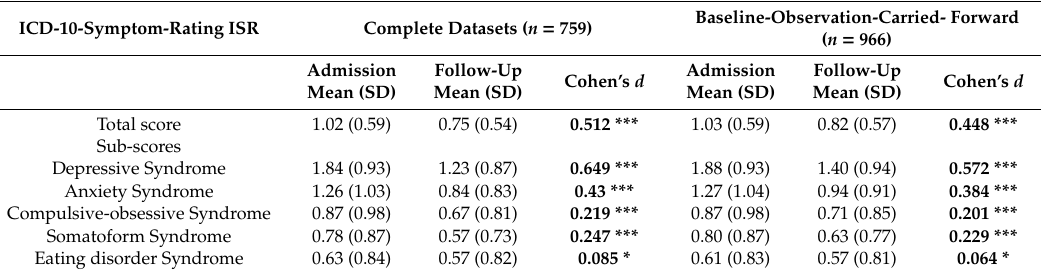
Table 6. Comparison of symptom loads between admission and follow-up of 759 patients with complete data sets and of 966 patients including 207 patients with baseline-observation-carried-forward (BOCF). ICD-10-Symptom-Rating ISR